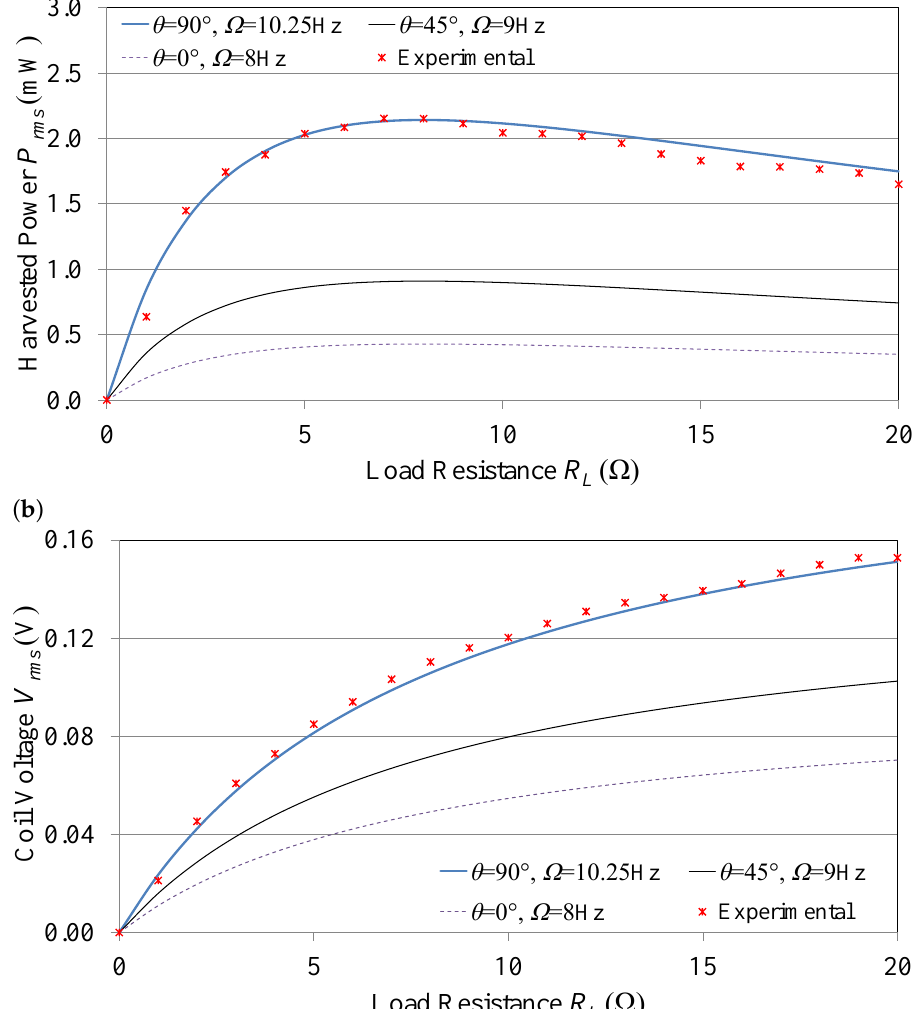
Figure 5. ( a ) Output voltage and ( b ) harvested